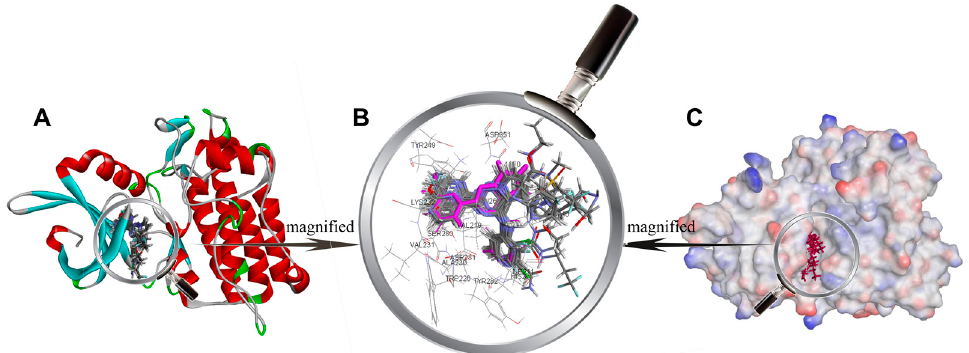
Figure 2. ( A ) Docked ligands in the binding pocket of TGF- β type 1 receptor (T β R1) displayed with solid ribbon, colored according to secondary structure, helices in red, beta sheets in cyan, turns in green, and coils in white. ( B ) binding of ligands in the active site—the purple one is a crystal structure pose of BMS22 (T β R1 inhibitor from Bristol-Myers Squibb, structure of which is detailed in Table S1) from the Protein Data Bank (PDB) ID: 6B8Y; ( C ) receptor surface colored by the interpolated atomic charge—blue represents a positive value and red represents a negative value.